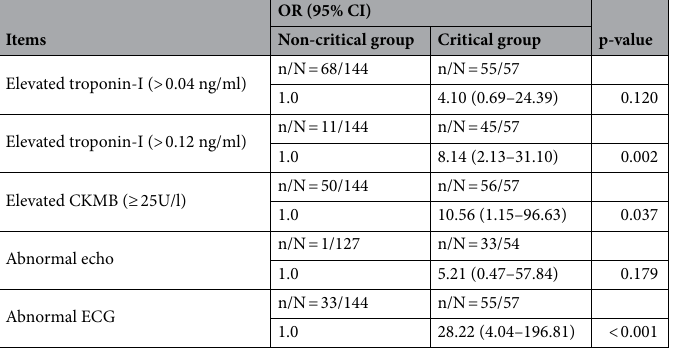
Table 4. Adjusted odds ratios (95% CI) of cardiac injury markers, by severity status ( n = 201). ORs were adjusted for age, gender, BMI, and comorbidity. Logistic regression. Non-critical was referent.